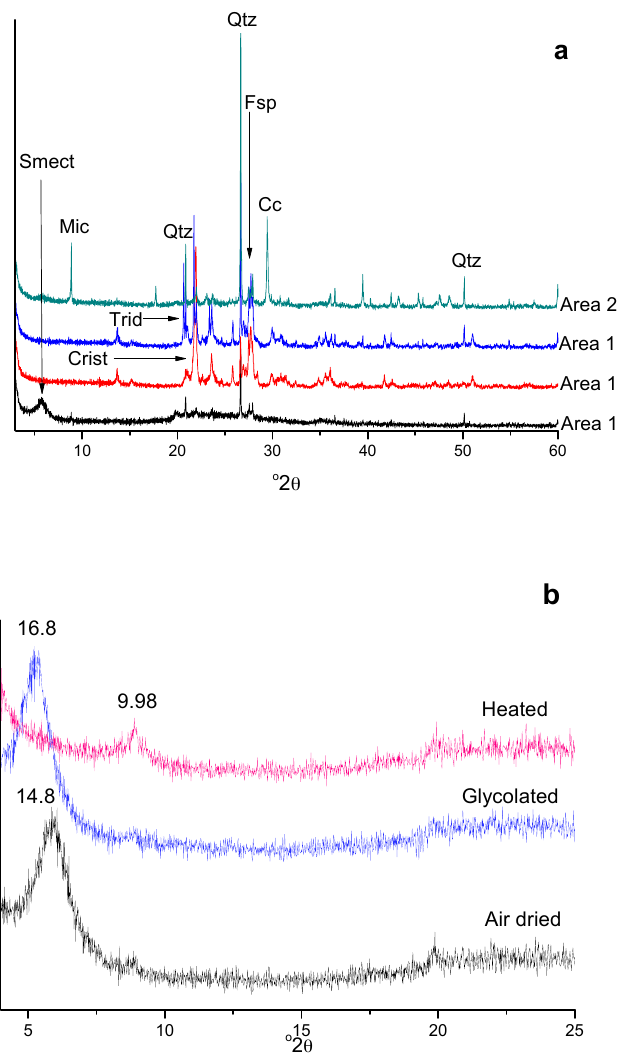
Figure 7. ( a ) XRD patterns of Samples of areas 1, 2 (Smect: smectite, Mic: Muscovite and illite, Trid: Tridymite, Crist; Cristobalite, Qtz: quartz, Fsp: feldspars, Cc: calcite); ( b ) XRD patterns of sample from area 1 air dried, glycolated and heated showing the presence of Smectite.